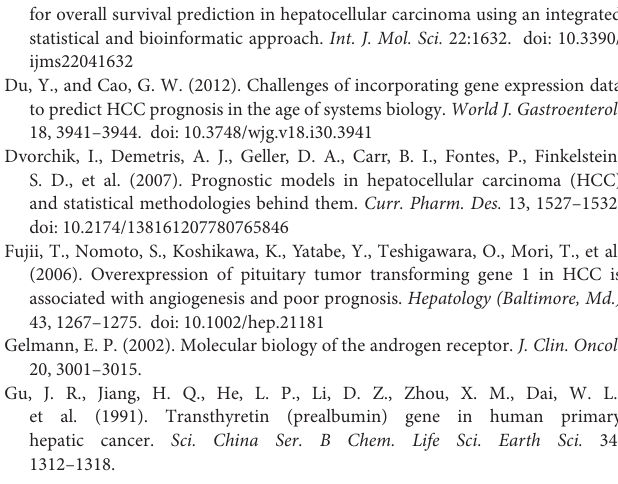
Supplementary Figure 1 | A 7-gene signature defined risk scoring was used to demonstrate the disease-free survival of patients with HCC after radical resection. Patients were classified into a low, intermediate, and high-risk group according to the risk scores. (A) A retrospective cohort of 129 patients. (B) A prospective cohort of 77 patients. Supplementary Figure 2 | A univariate Cox hazard model for the association of clinicopathological characteristics and overall survival in patients with HCC after radical resection. (A) A retrospective cohort of 129 patients for tumor size. (B) A prospective cohort of 77 patients for tumor size. (C) A retrospective cohort of 129 patients for histopathological differentiation. (D) A prospective cohort of 77 patients for histopathological differentiation. Supplementary Figure 3 | The correlation between clinicopathological characteristics and risk score in patients with HCC after radical resection. (A) A retrospective cohort of 129 patients for tumor size. (B) A prospective cohort of 77 patients for tumor size. (C) A retrospective cohort of 129 patients for histopathological differentiation. (D) A prospective cohort of 77 patients for histopathological